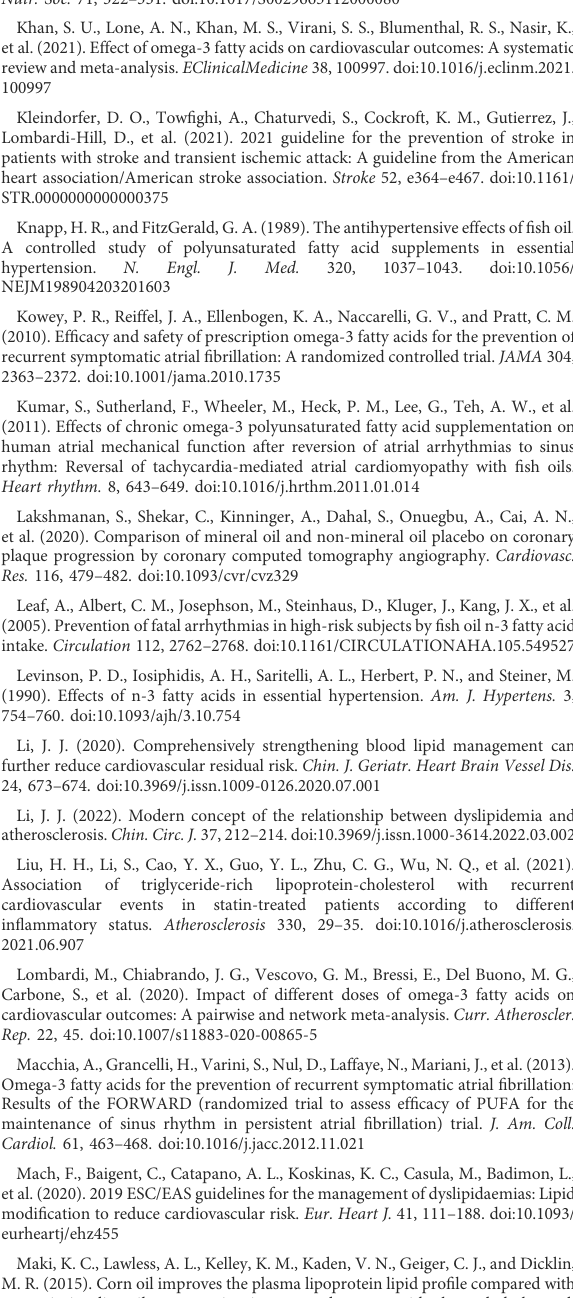
European Medicines Agency (2019). Omega-3 acid ethyl esters - containing medicinal products for oral in use in secondary prevention after